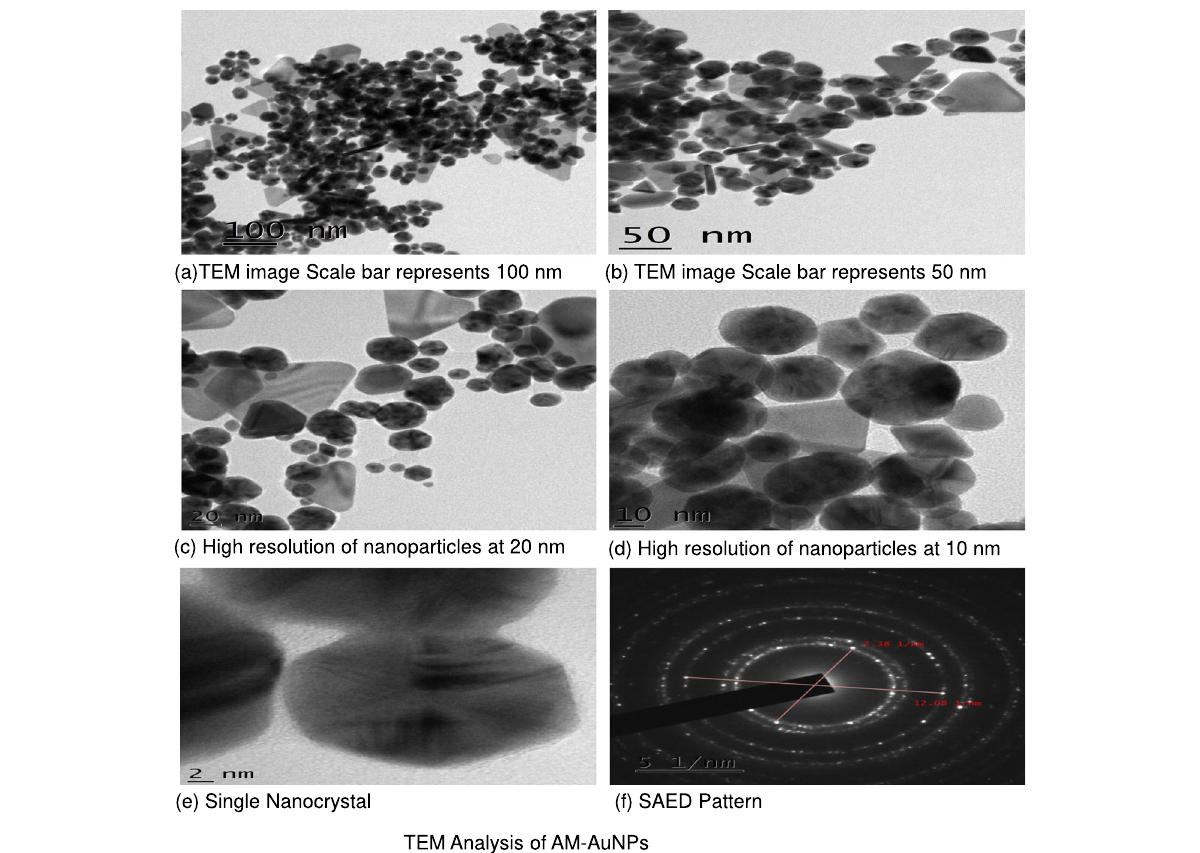
Fig. 2 TEM analysis of AM-AuNPs ( a ). Image of AM-AuNPs where scale bar represents 100 nm ( b ). Scale bar represents 50 nm ( c ). High-resolution of nanoparticles at 20 nm ( d ) and 10 nm ( e ). Single nanocrystal ( f ) SAED